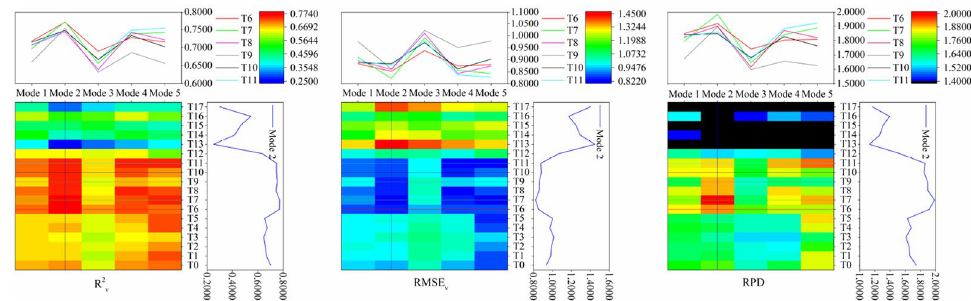
Figure 6. Validation of PLSR models in different